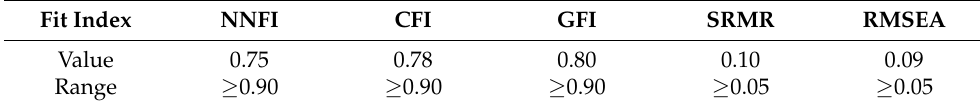
Table 6. Goodness-of-Fit Indices of Confirmatory Factor